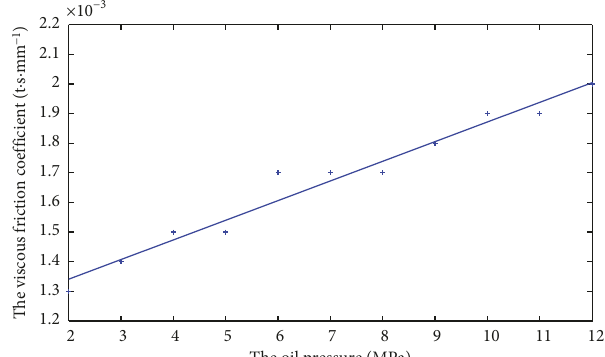
Figure 19: Effect of pressure change on the viscous friction coefficient.